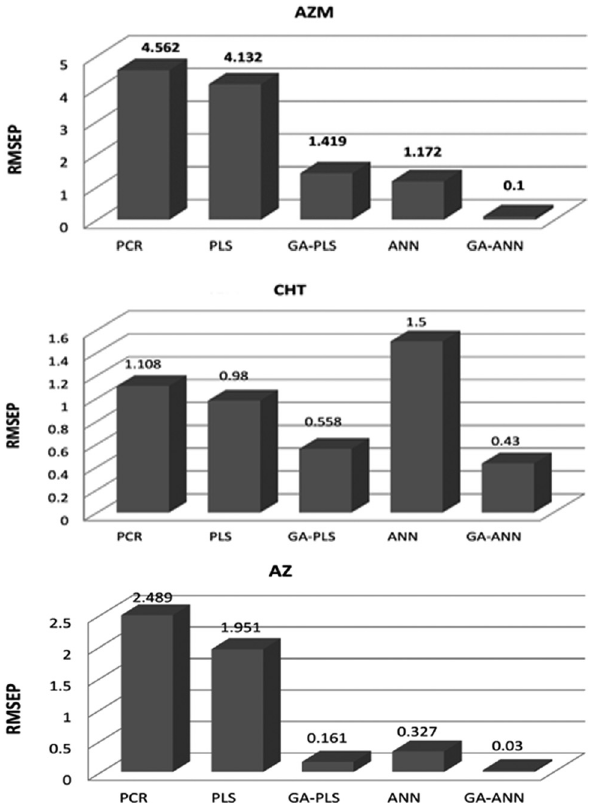
Figure 5: Bar plots for comparison of the RMSEP values obtained by application of the fi ve adopted chemometric